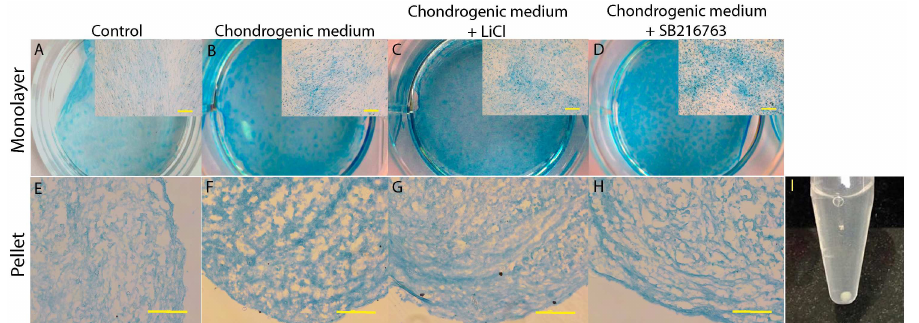
Fig 4. Accumulation of GAGs was stained by alcian blue. (A-D) Photographs of monolayerexpanded cells cultured for 2 weeks. Scale bar = 10 μ m. (E-H) Pellets culture at 4 weeks after differentiation. Scale bar = 20 μ m. (I) Morphology of pellet culture at 4 weeks after